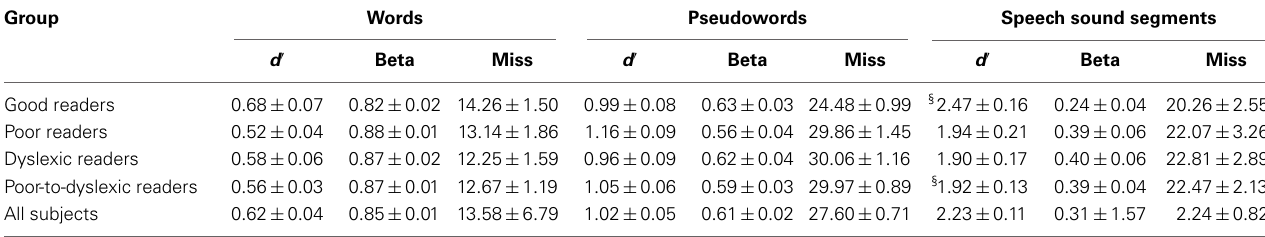
Table 3 | Restoration by